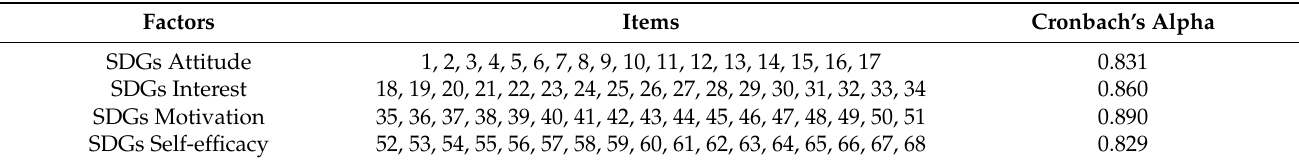
Table 4. Reliability estimates for SDGPI.